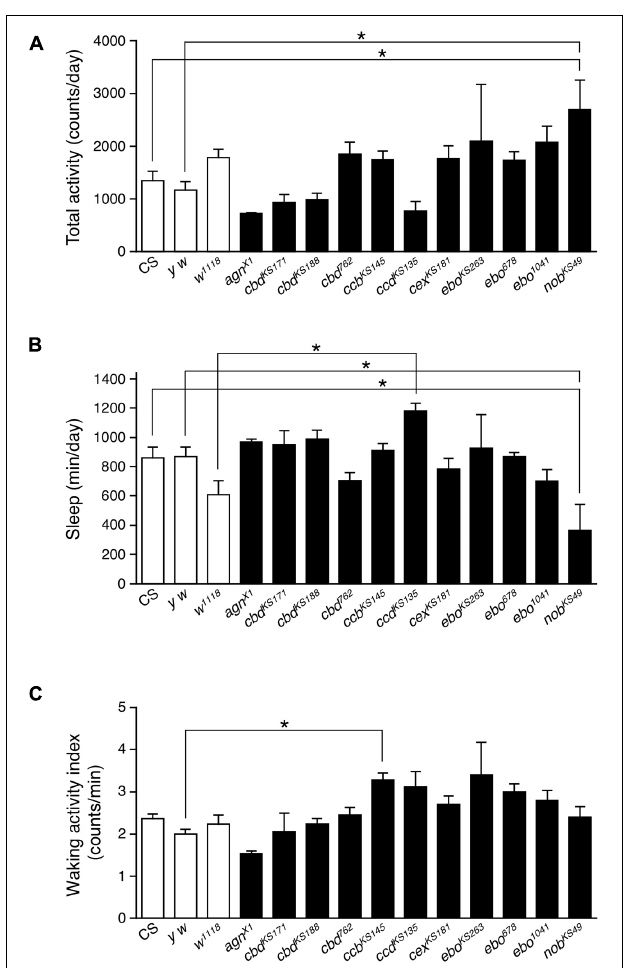
FIGURE 1 | The PB defective nob KS49 decreased sleep. Total daily activity (A) , total sleep (B) and waking activity index (C) for control flies (Canton-S, y w and w 1118 , white bars) and mutant strains with structural defects in the central complex (black bars) in constant dark (DD) conditions. Data are averaged for 3 days and are presented as mean ± standard error of the mean (SEM) ( n = 3–11 for each group). Groups with asterisks indicate statistically significant differences from controls (one-way ANOVA followed by Tukey-Kramer post hoc test, p <